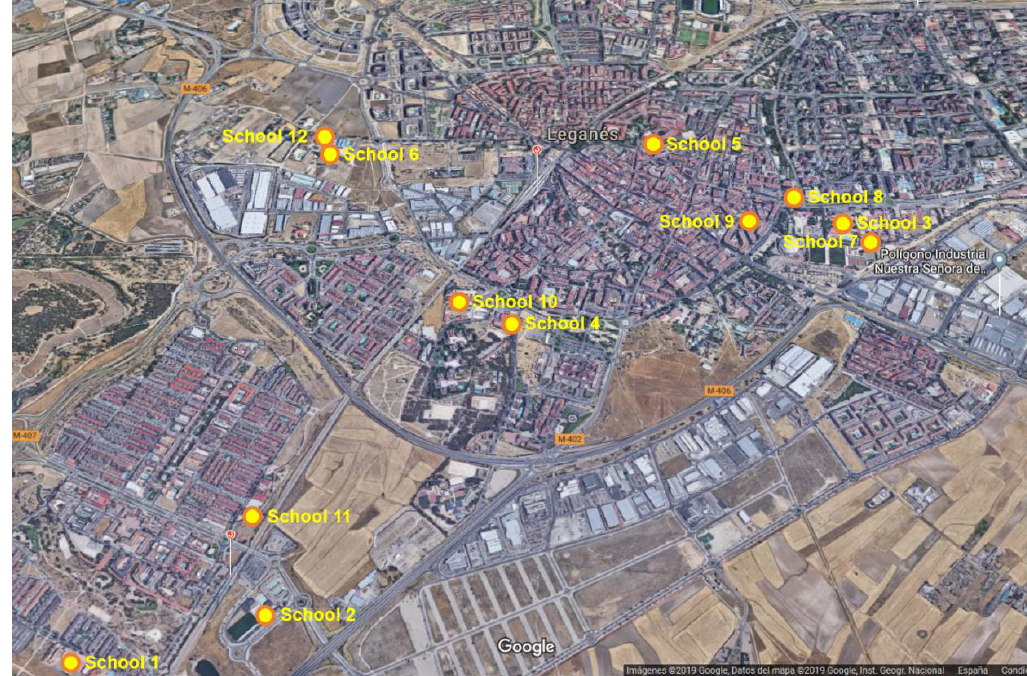
Figure 1. Aerial view of the Leganés municipality (southern metropolitan area of Madrid) indicating the exact geographical location of the 12 primary and secondary schools sampled in the present study.